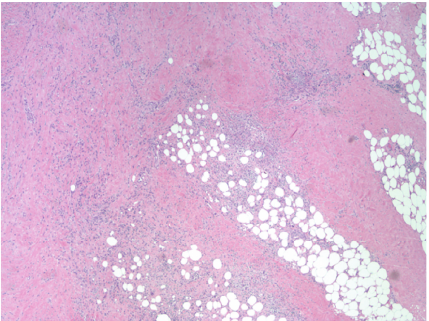
Figure 5: Pericardium with prominent scar tissue and nodular aggregate of monocytes and macrophages. Magnification